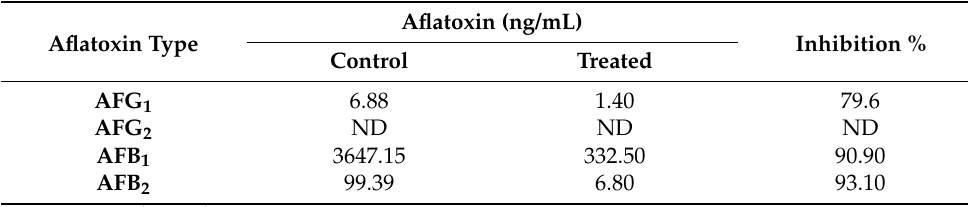
Table 1. In-vitro inhibition percentages of aflatoxins using endophytic A. fumigatus. Aflatoxin Type